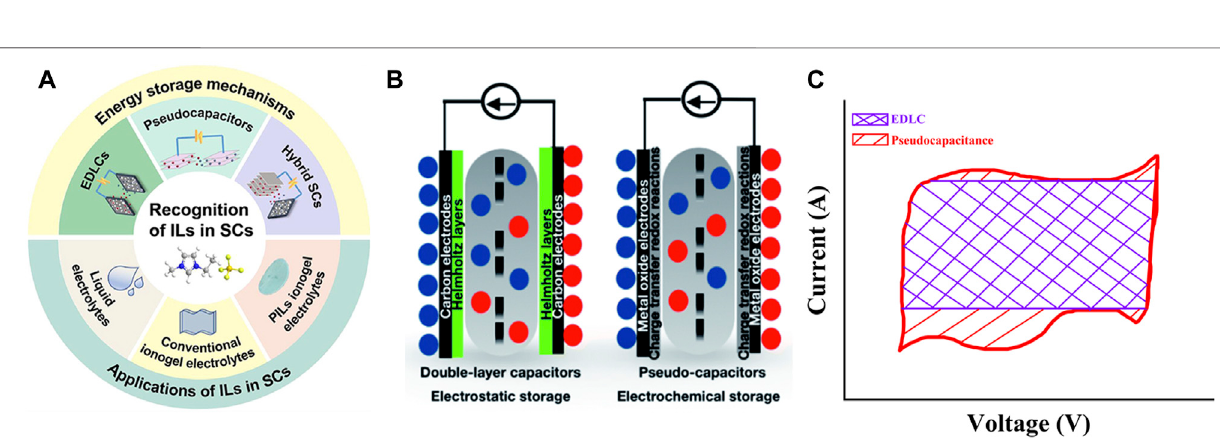
Frontiers in Energy Research |